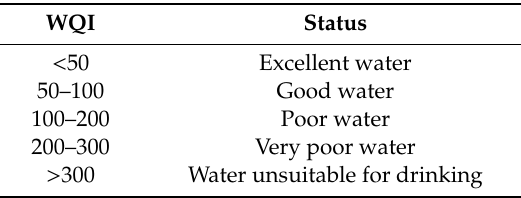
Table 1. Water quality index (WQI) classification